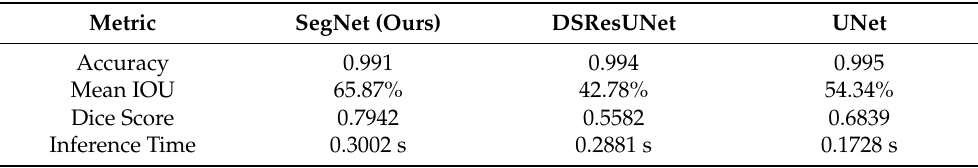
Table 2. Evaluation metrics for our trained Chronoroot model comparisons with our trained Seg- Net